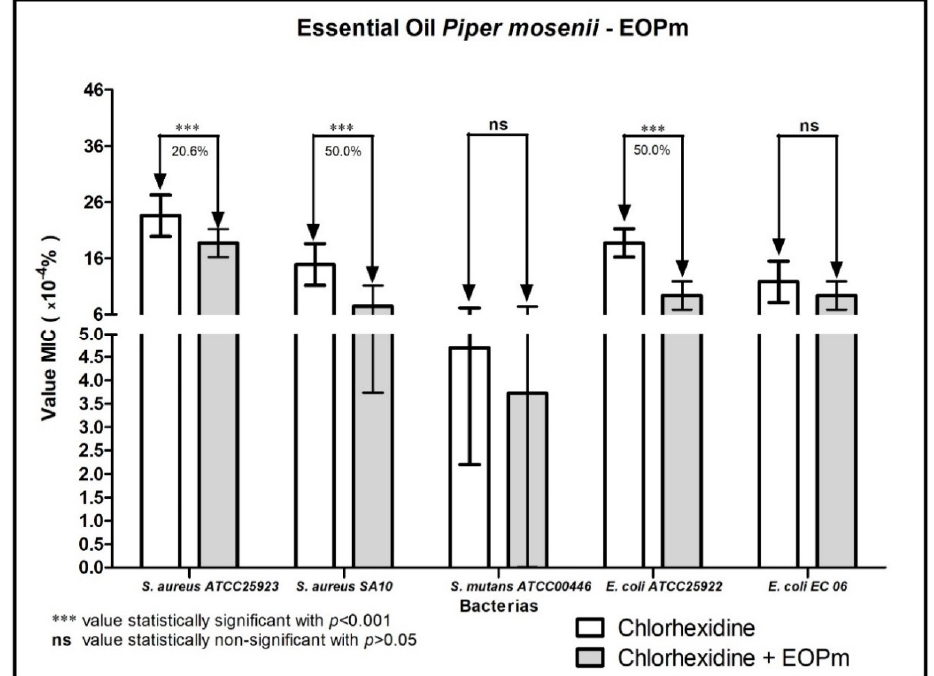
Figure 1. Evaluation of the modulatory activity of EOPm combined with Chlorhexidine against bacterial strains.